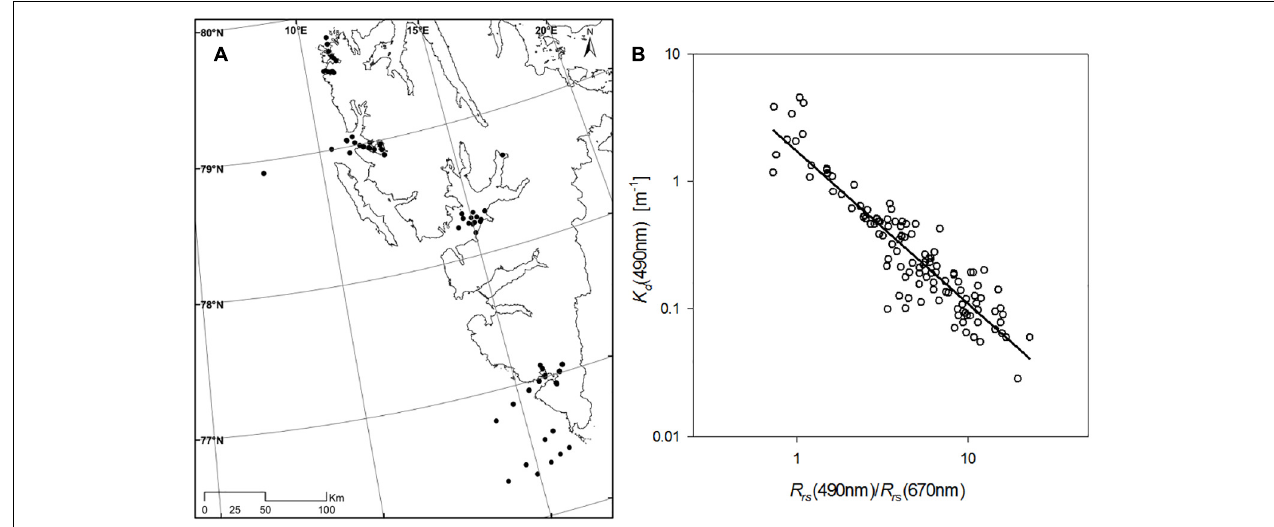
FIGURE 2 | Location of the in situ measurements of K d (490) used to develop a formula for satellite K d (490) computation (A) and the relationship between the K d (490) and the R rs (490)/ R rs (670) band ratio with the regression applied in this study (line marked in black) (B) .